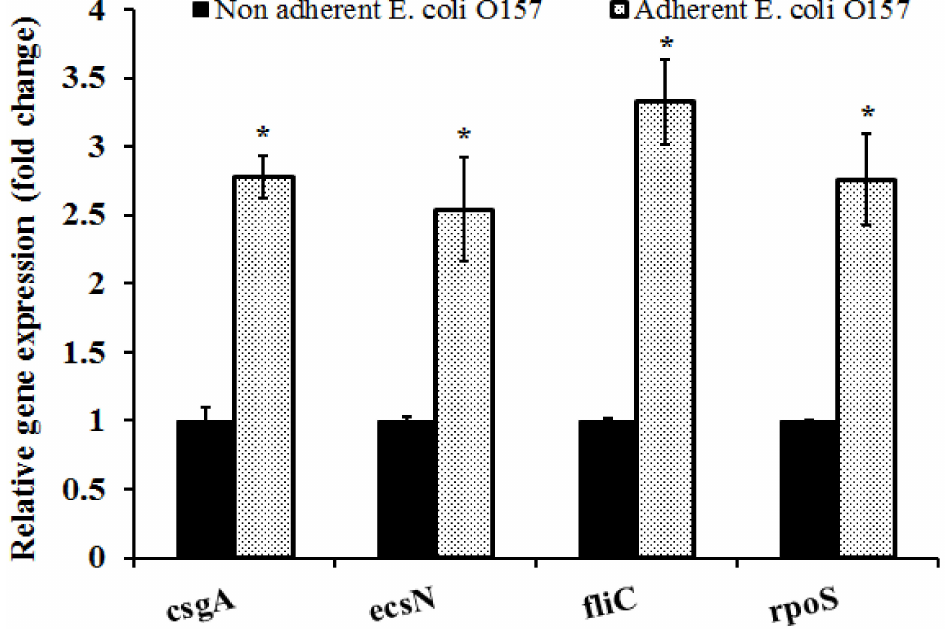
Figure 3. Differences in the expression of adhesin and stress response genes as determined by RTqPCR. Gene expression was assayed using the StepOne Plus Real-Time PCR System. The data were normalized to the endogenous control (Gapdh) and the level of candidate gene expression between E. coli O157 cells in the inoculum and those retrieved from the nut surface was compared to study relative gene expression. * Expression of candidate genes in the adherent cells were significantly different from the non-adherent cells at p <